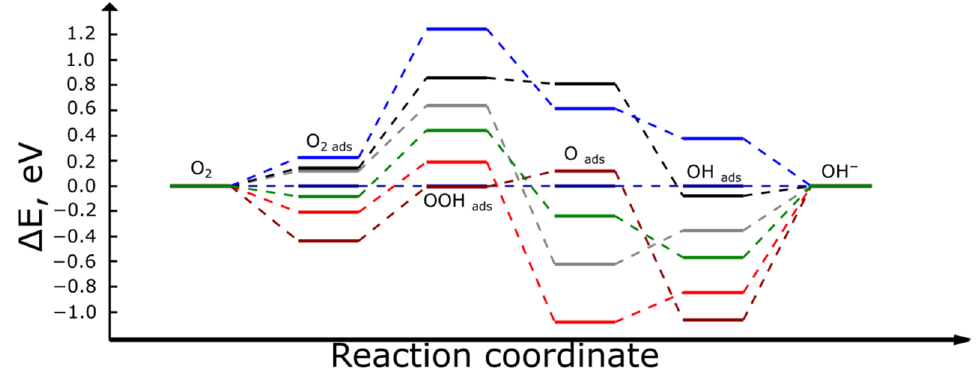
Figure 5. Overpotential on catalysts.